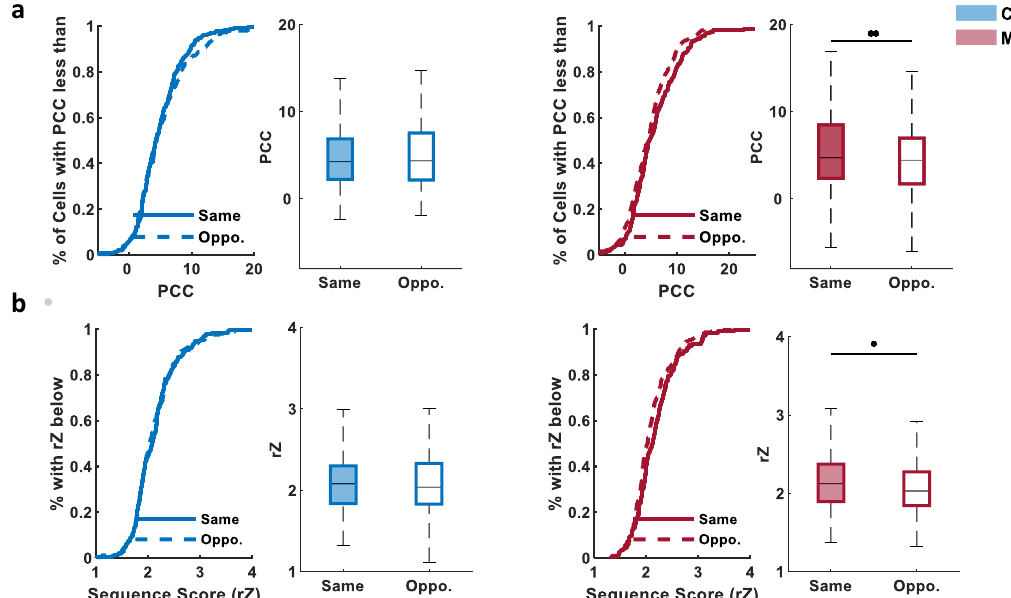
Fig. 5 CA3 input is required for bilateral coordination of replay sequences in CA1. a Per cell contribution (PCC) of single neuron to replay events during SWRs from the same and opposite hemisphere was similar in control mice, but in mutants neurons from the same hemisphere with ripple had signi fi cantly higher contribution (CTR, N = 4 mice, n (left cell + left ripple) = 145, n (right cell + left ripple) = 116, n (left cell + right ripple) = 139, n (right cell + right ripple) = 115, n (same hemisphere) = 260, n (opposite hemispheres) = 255, P = 0.5167; MUT, N = 5 mice, n (left cell + left ripple) = 155, n (right cell + left ripple) = 148, n (left cell + right ripple) = 118, n (right cell + right ripple) = 117, n (same hemisphere) = 267, n (opposite hemispheres) = 271, P = 0.0061). b Signi fi cant replay events decoded with cells from a single hemisphere during SWRs detected in the same or opposite hemisphere were of similar quality in control mice, whereas in mutants replay quality was signi fi cantly lower when only contralateral neurons were used (CTR: N = 4 animals, n (left cells + left ripple) = 136 events, n (right cells + right ripple) = 112 events, n (same hemisphere in total) = 248 events; n (left cells + right ripple) = 186 events, n (right cells + left ripple) = 65 events, n (opposite hemisphere in total) = 251 events, P = 0.8796; MUT: N = 5 animals, n (left cells + left ripple) = 99 events, n (right cells + right ripple) = 116 events, n (same hemisphere in total) = 196 events; n (left cells + right ripple) = 127 events, n (right cells + left ripple) = 80 events, n (opposite hemisphere in total) = 207 events, P = 0.0346). All signi fi cant difference in Fig. 5 were tested with